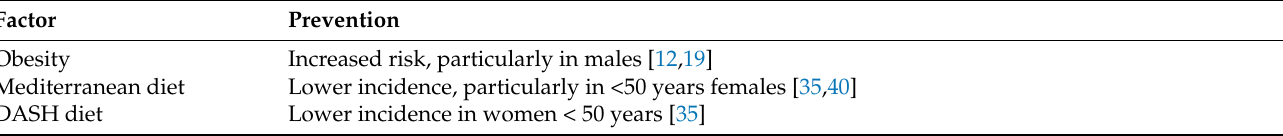
Table 1. Summary of the main relationships between nutritional factors and melanoma